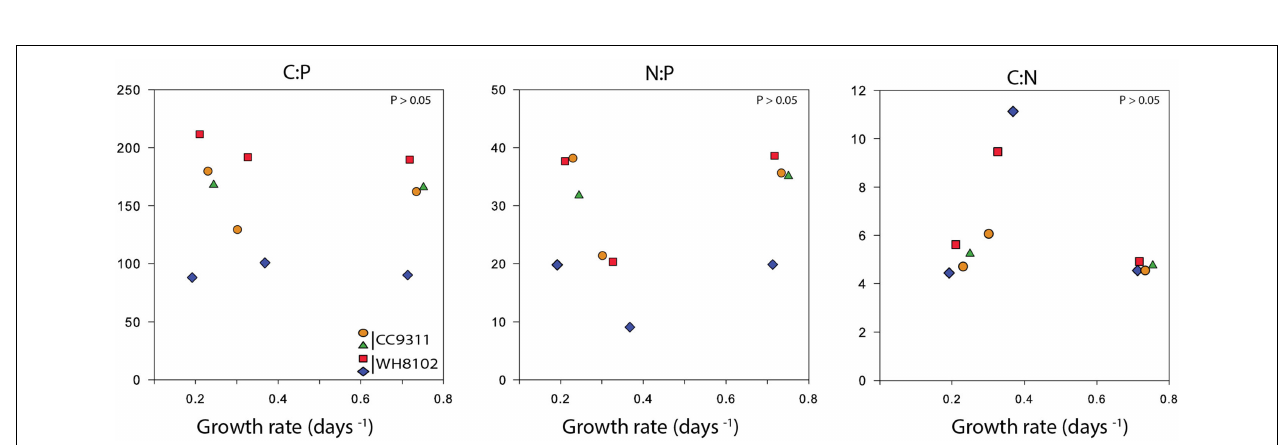
FIGURE 2 | Comparison of cellular C:N:P ratios for strains WH8102 and CC9311 and the Redfield ratio (106:16:1). The average between the strains are represented. The error bar represent the standard error between the technical replicates. C:N:P between strains were not statistically different